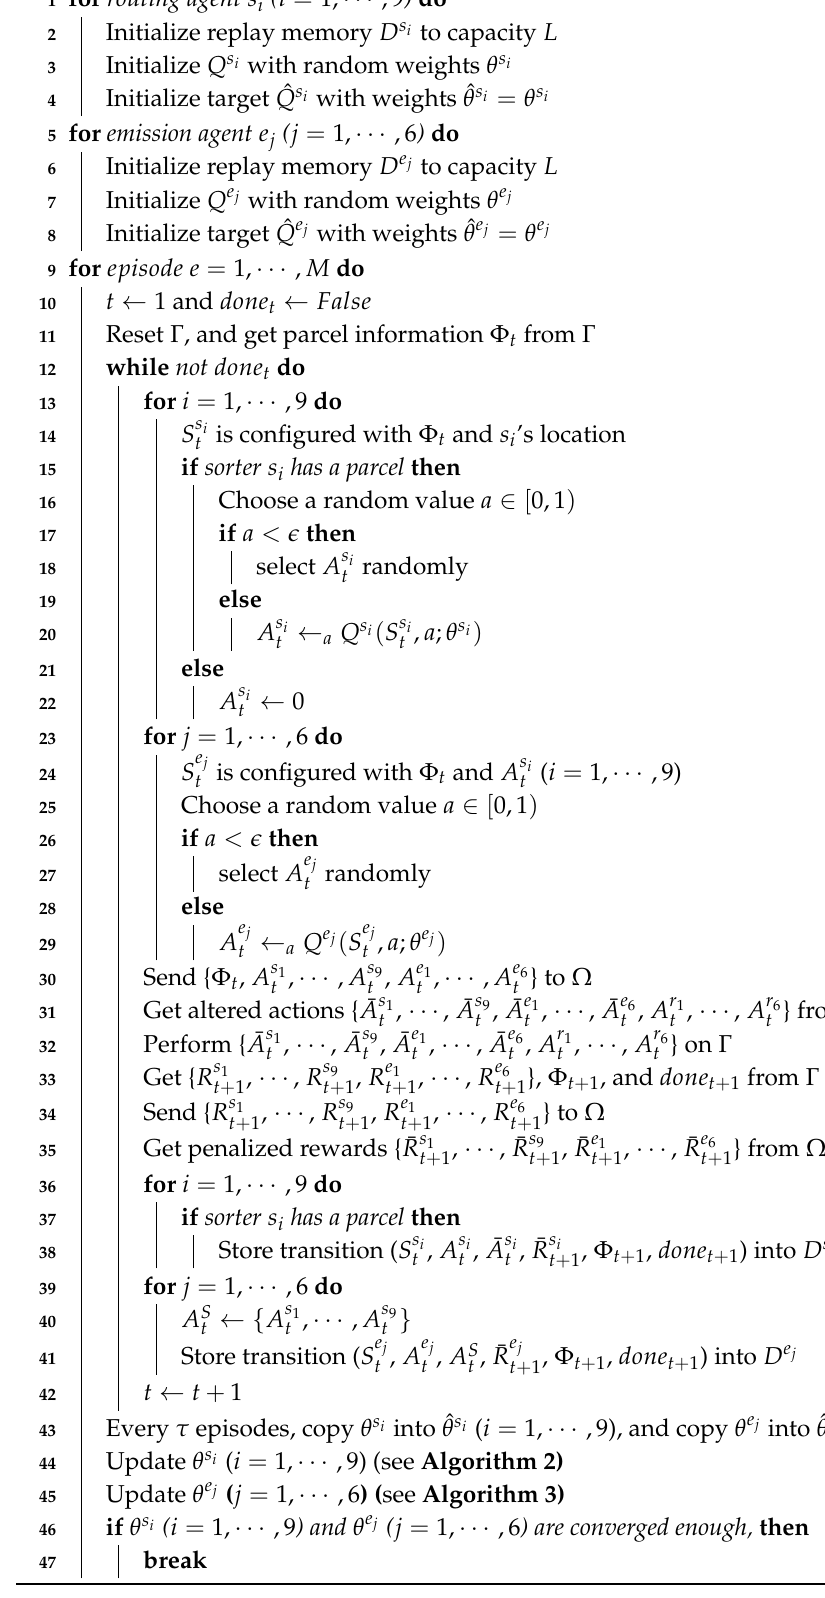
Algorithm 1: The proposed multi-agent RL algorithm ( Γ : target system, Ω : collision resolver [ 0, 1 ] : exploration and penalty generator, e ∈